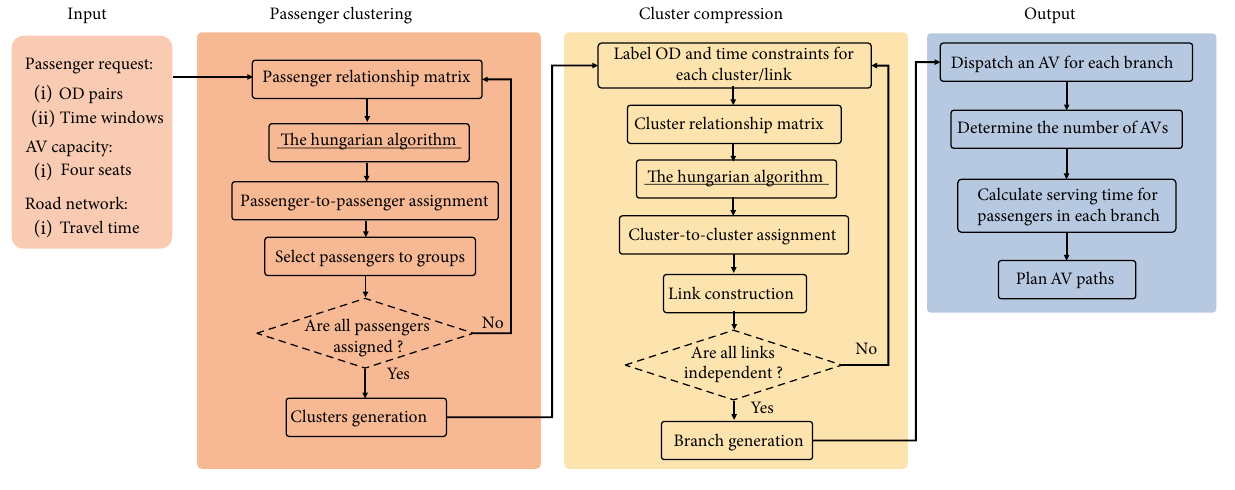
Figure 2: The flow chart of the cluster-based algorithm.